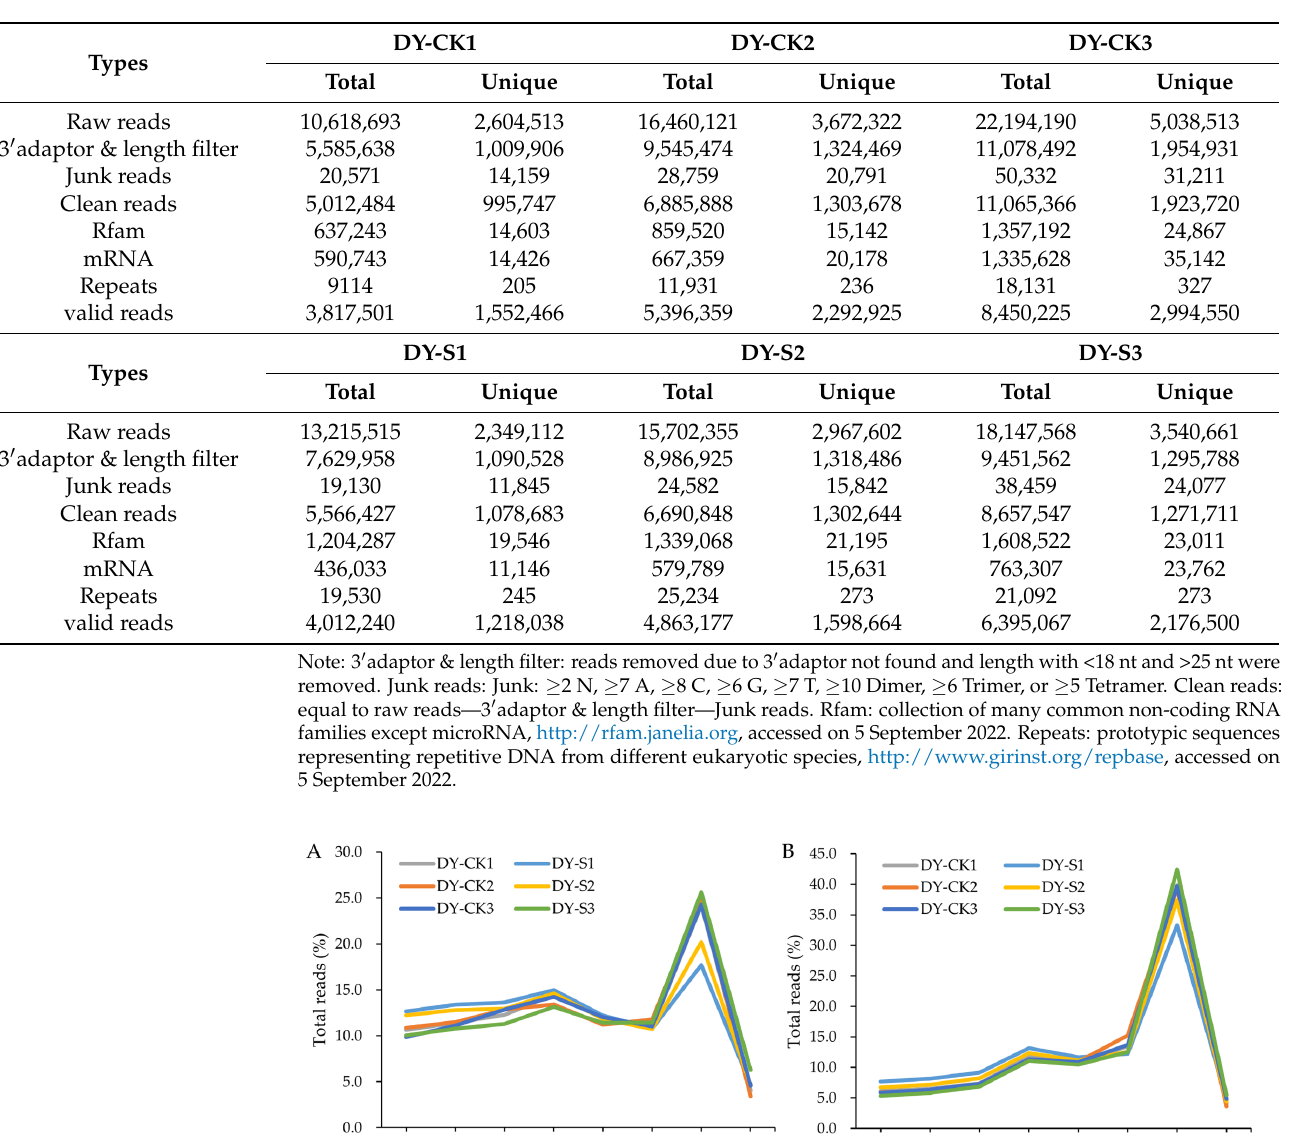
Table 1. Summary of small RNA sequencing in the DXWR at control and salt stress conditions.